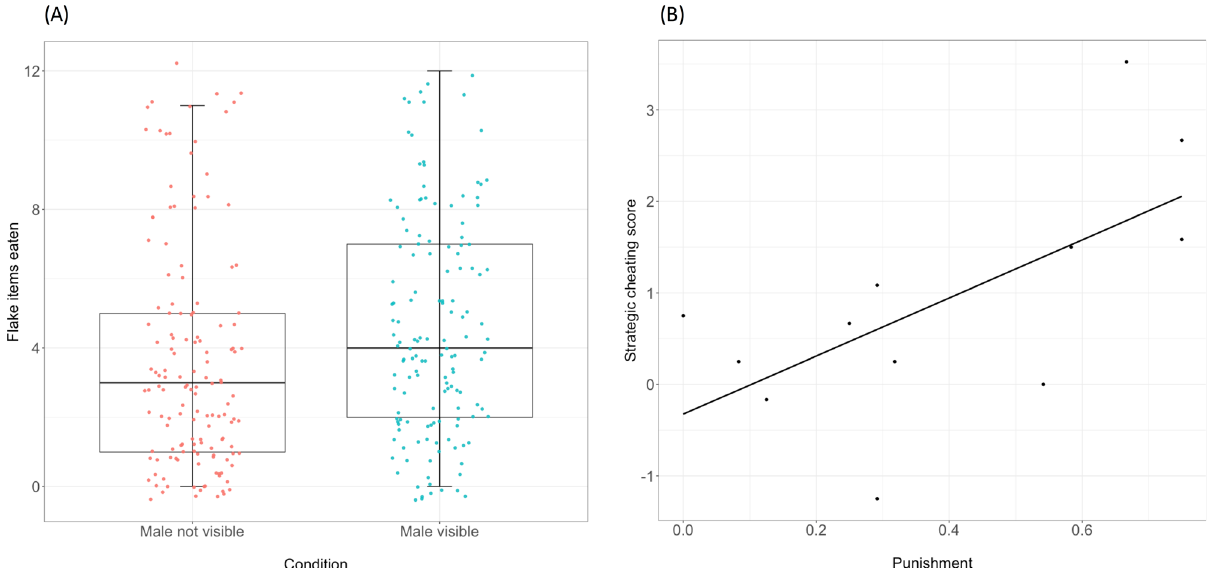
Fig. 2 Flake items eaten by females and female strategic cheating scores from Study 1. Results from Study 1 ( N = 12 pairs of fi sh). A Boxplot showing fl ake items eaten by females across conditions along with raw data (For fl ake items eaten by pairs see Supplementary Fig. S1). Box shows the interquartile range, the horizontal line shows the median, the whiskers stretch from the minimum to maximum and raw data are overlaid as dots colored by condition. B Plot showing the relationship between female strategic cheating score and male